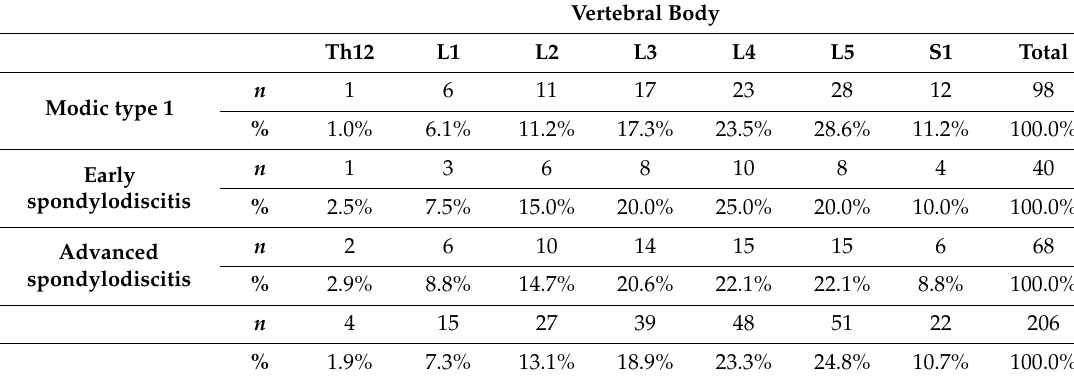
Table 6. Site of vertebral body